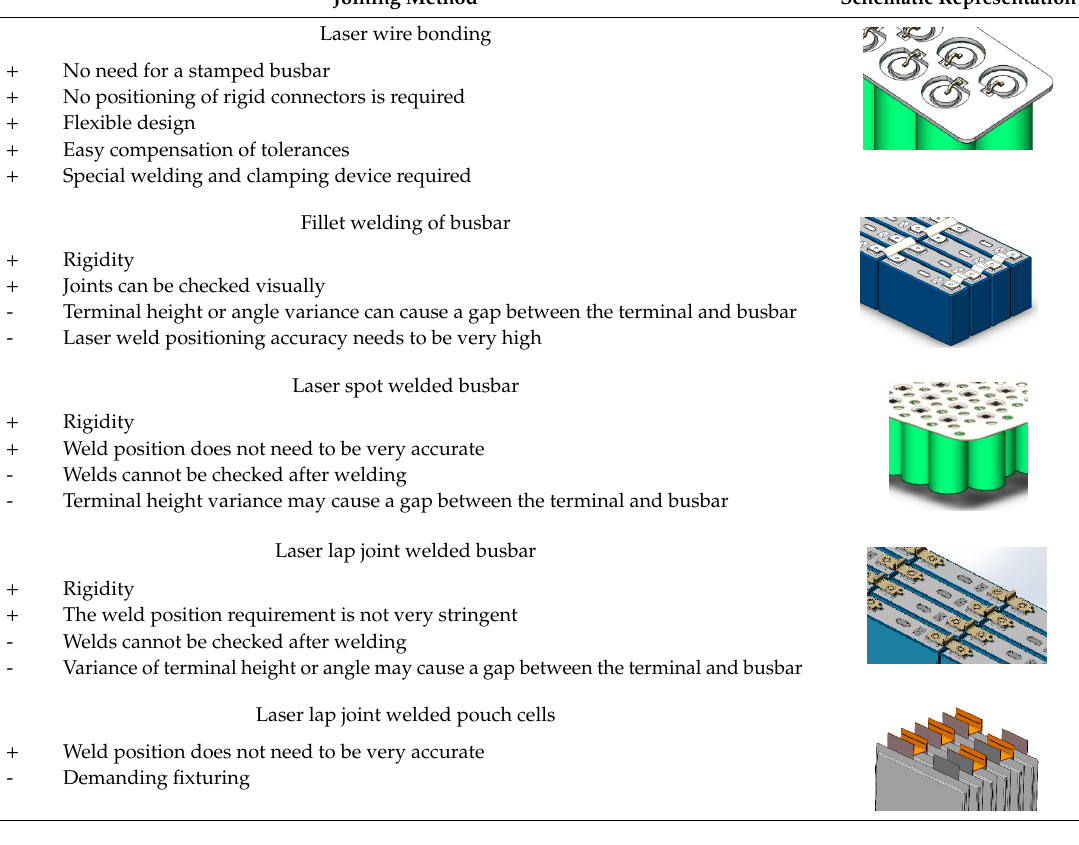
Table 1. Comparison of di ff erent battery assembly methods by laser welding. Schematic images represent commercially available industrial solutions. Table 1. Comparison of different battery assembly methods by laser welding. Schematic images represent commercially available industrial solutions. Table 1. Comparison of different battery assembly methods by laser welding. Schematic images represent commercially available industrial solutions. Table 1. Comparison of different battery assembly methods by laser welding. Schematic images represent commercially available industrial solutions. Table 1. Comparison of different battery assembly methods by laser welding. Schematic images Table 1. Comparison of different battery assembly methods by laser welding. Schematic images represent commercially available industrial solutions. represent commercially available industrial